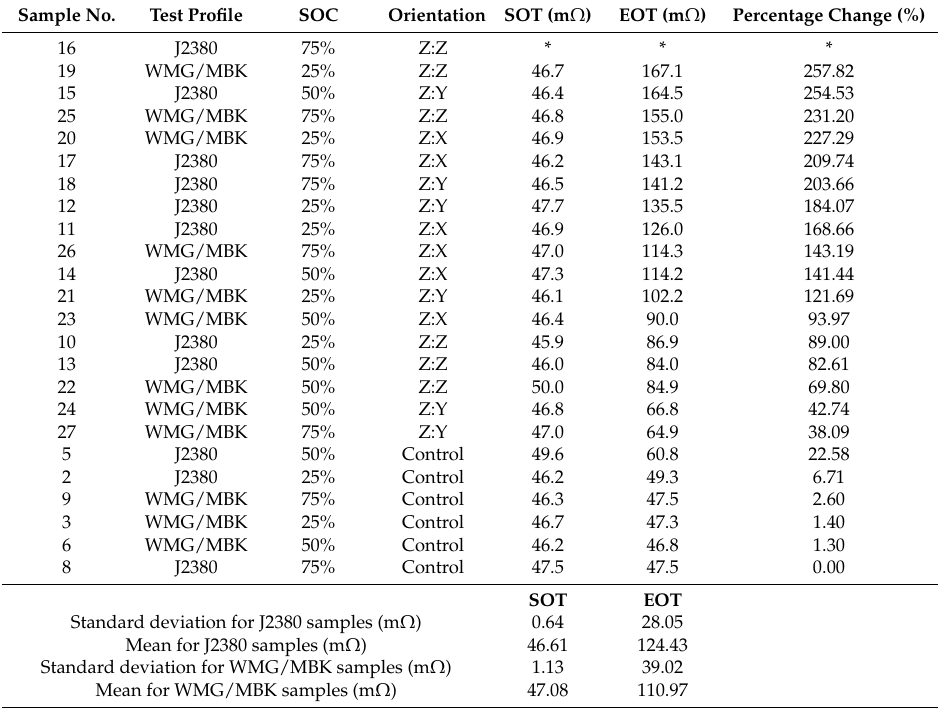
Table 12. electrochemical impedance spectroscopy (EIS) ohmic resistance (R o ) results for all tested samples.